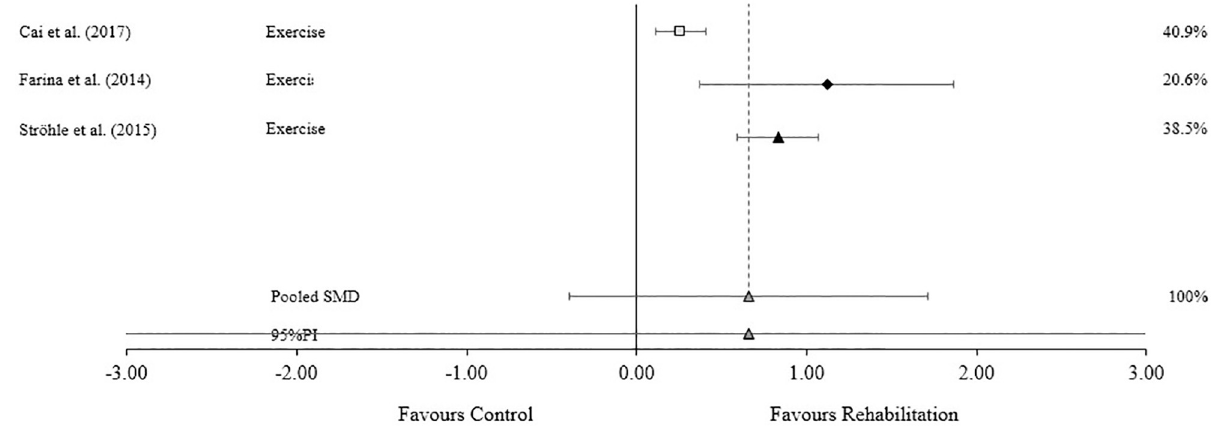
Fig 5. Standardized mean difference (SMD) for global cognitive measures. (cid:2) Trivial effect ■ Small effect ▲ Moderate effect ◆ Large effect. Forest plot to illustrate the standardized mean differences (SMD) (95% confidence intervals) for studies evaluating the effect that active rehabilitation has on measures of cognitive function.